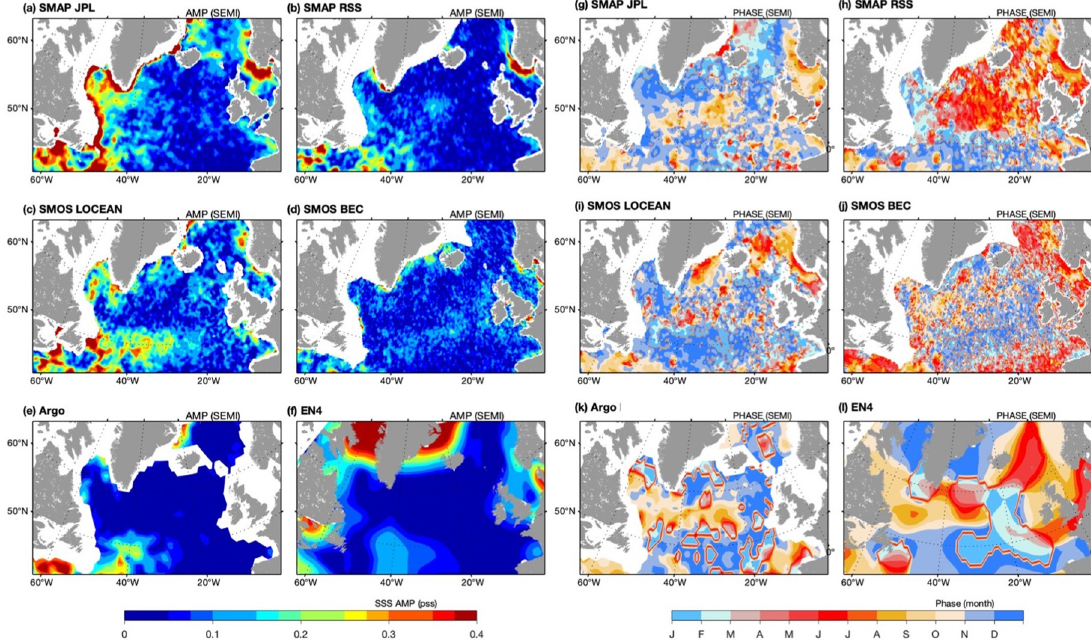
Figure 6. ( a )–( f ) and phases ( g )–( l ) of the annual SSS cycle for the semiannual SSS cycle for all six